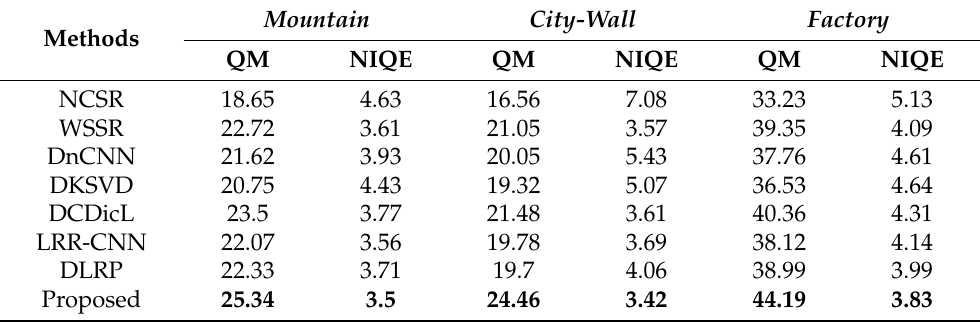
Table 3. Quantitative comparisons of the QM and NIQE values produced by the state-of-the-art. For each image, the best result is marked with bold